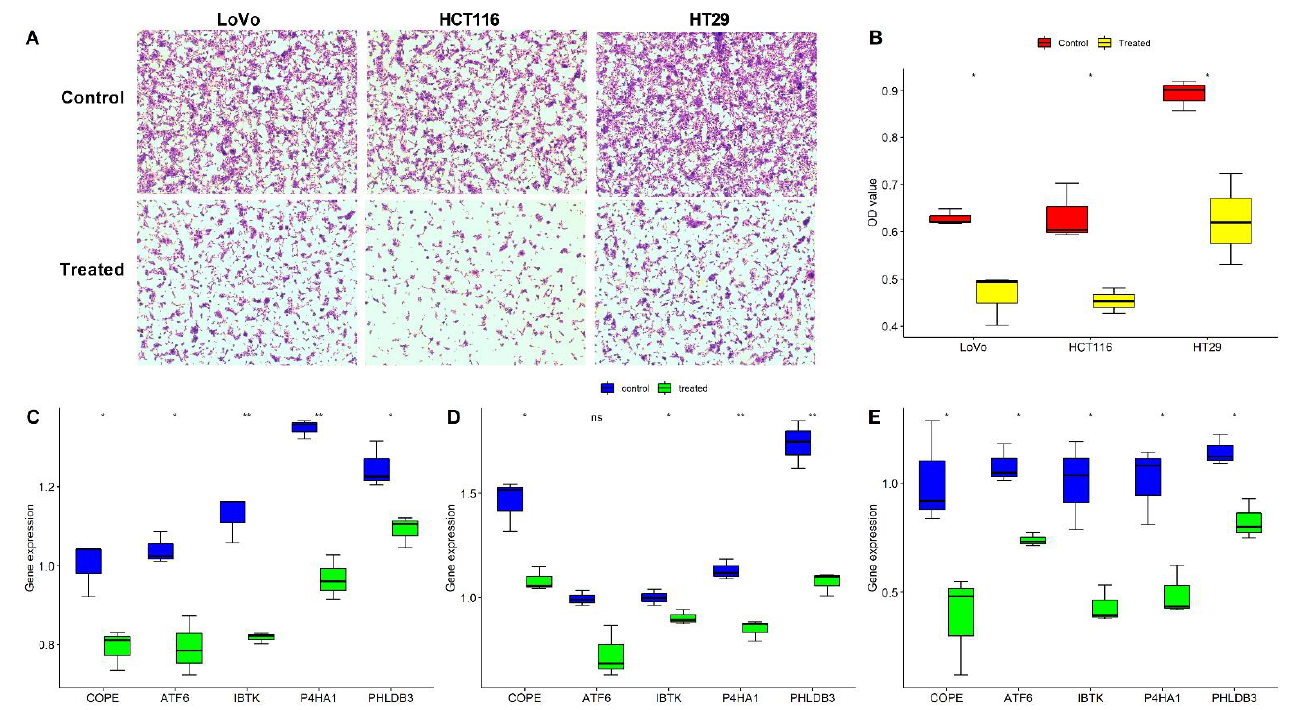
Figure 5. Validation of the five oxaliplatin-resistant genes in HCT116, HT-29, and LoVo CRC cells. ( A ) Cell proliferation morphology after treatment with oxaliplatin for 24 h; ( B ) CCK-8 assay revealing the cell proliferation after treatment with oxaliplatin; comparison of the five oxaliplatin-resistant gene expressions after treatment with oxaliplatin tested by RT-PCR assay in ( C ) HCT116, ( D ) HT-29, and ( E ) LoVo. * p < 0.05, ** p < 0.01, ns: not significant.